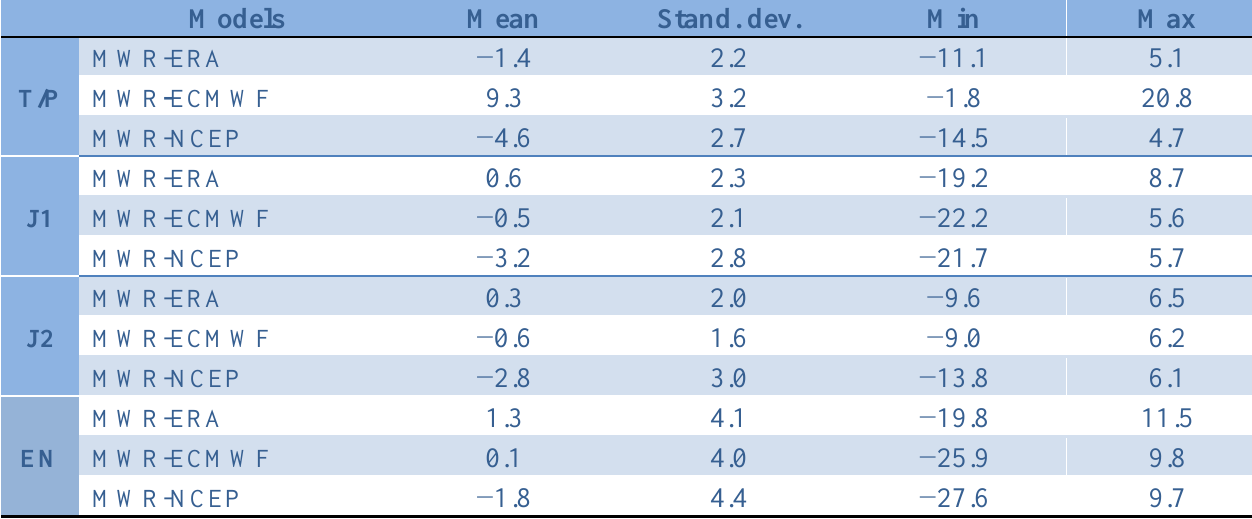
Table 2. Statistical parameters (in cm) of the comparison of the various WTC for Lake Victoria. Values refer to the differences for the following periods of each mission: